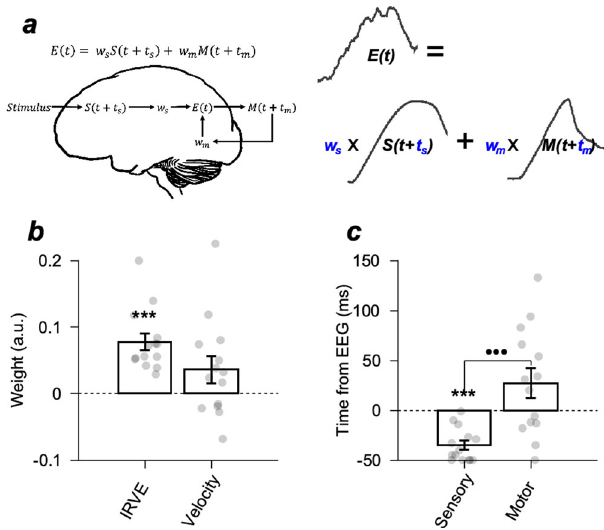
Fig. 6 Description of the linear model and estimated